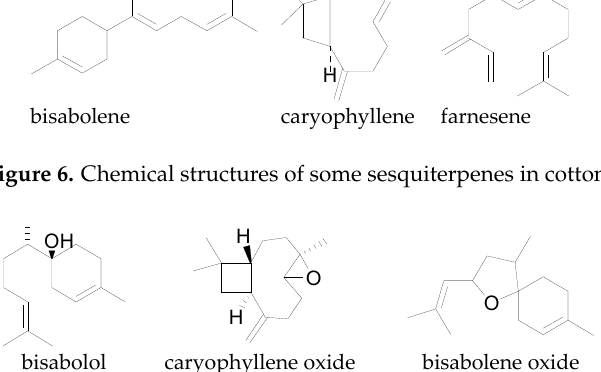
Figure 7 . Some sesquiterpenoids isolated from cotton.